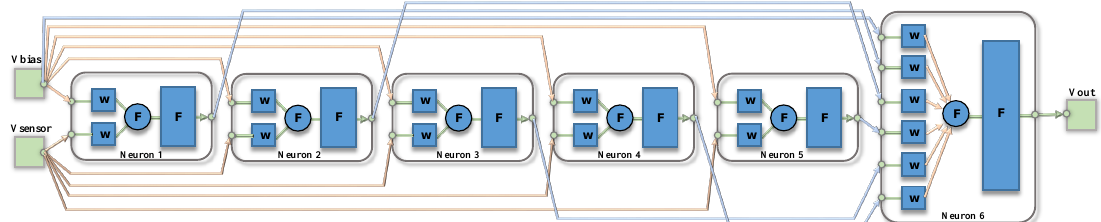
Figure 19. 1-5-1 network Matlab definition for studying the effect of mismatch between